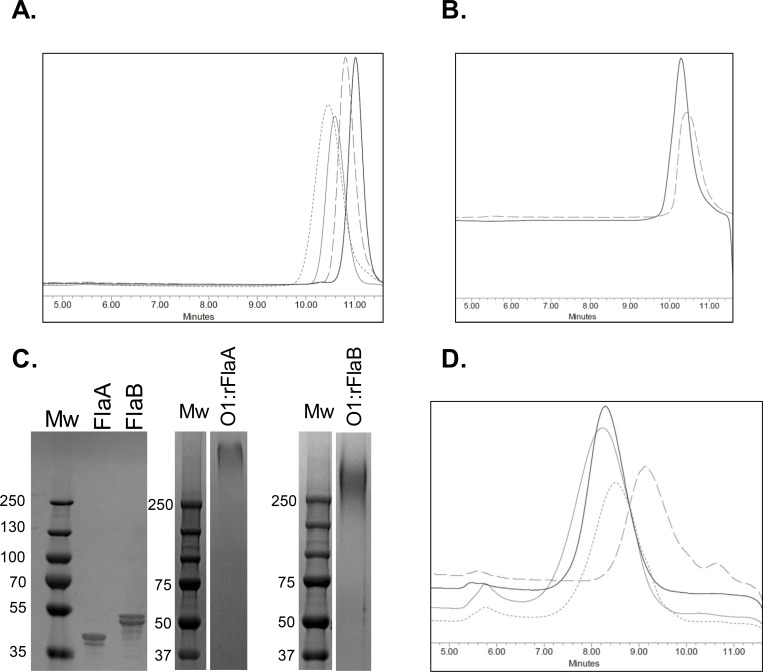
Biochemical and biophysical characteristics of purified KP OPS, PA flagellin antigens and conjugates.(A) HPLC-SEC with RI detection for purified KP O1 (short dash trace), O2 (long dash trace), O3 (thin black trace) and O5 (thick black trace) OPS molecules. (B) HPLC-SEC for rFlaA (dash trace) and rFlaB (solid trace) proteins. (C) SDS-PAGE and Coomassie stain of rFlaA or rFlaB, alone or conjugated to KP O1 OPS (O1:rFlaA and O1:rFlaB). Mw = molecular weight marker. (D) HPLC-SEC for O1:rFlaB (thin black trace), O2:rFlaA (long dash trace), O3:rFlaB (short dash trace), O5:rFlaA (thick black trace).